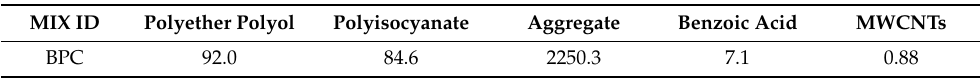
Table 2. Mixture design of